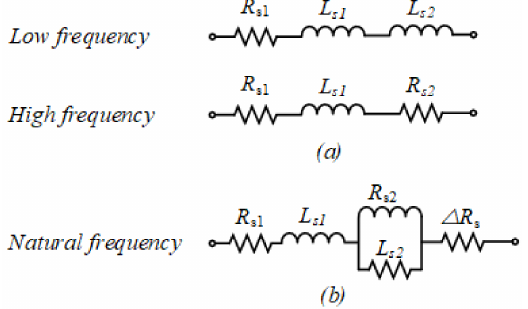
Figure 5. SC equivalent circuit at different frequency in